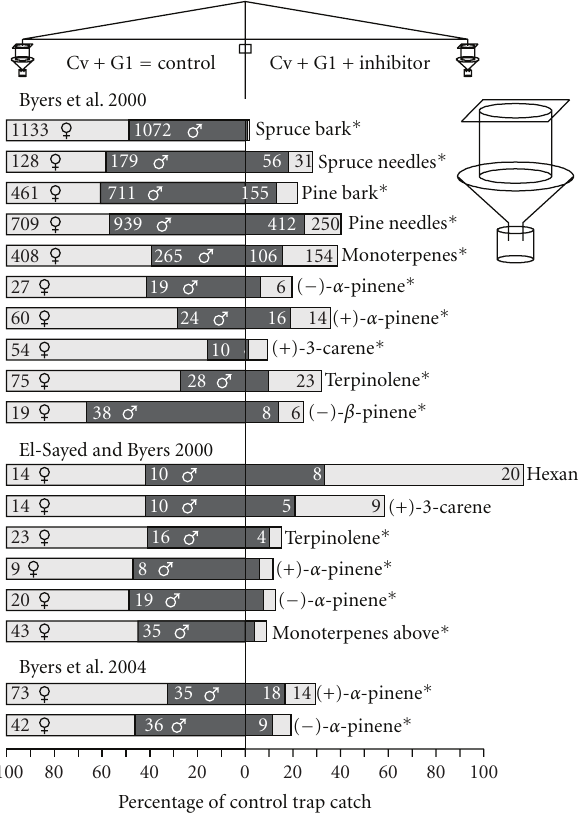
Figure 1: Selected comparisons from three studies (Byers et al. [7], El-Sayed and Byers [9], and Byers et al. [8]) showing reduced catches of flying Pityogenes bidentatus on traps releasing pheromone plus inhibitor volatiles (monoterpenes released at 1mg/day, 100– 200 g bark or needles of spruce and pine) compared to control traps with pheromone alone (Sj¨obo/Veber¨od, Sweden, April-May 1998– 2000, see Methods for details). Total catches of both sexes with asterisks were significantly lower than the pheromone controls in the same test at P < 0 . 01 (chi-square goodness of